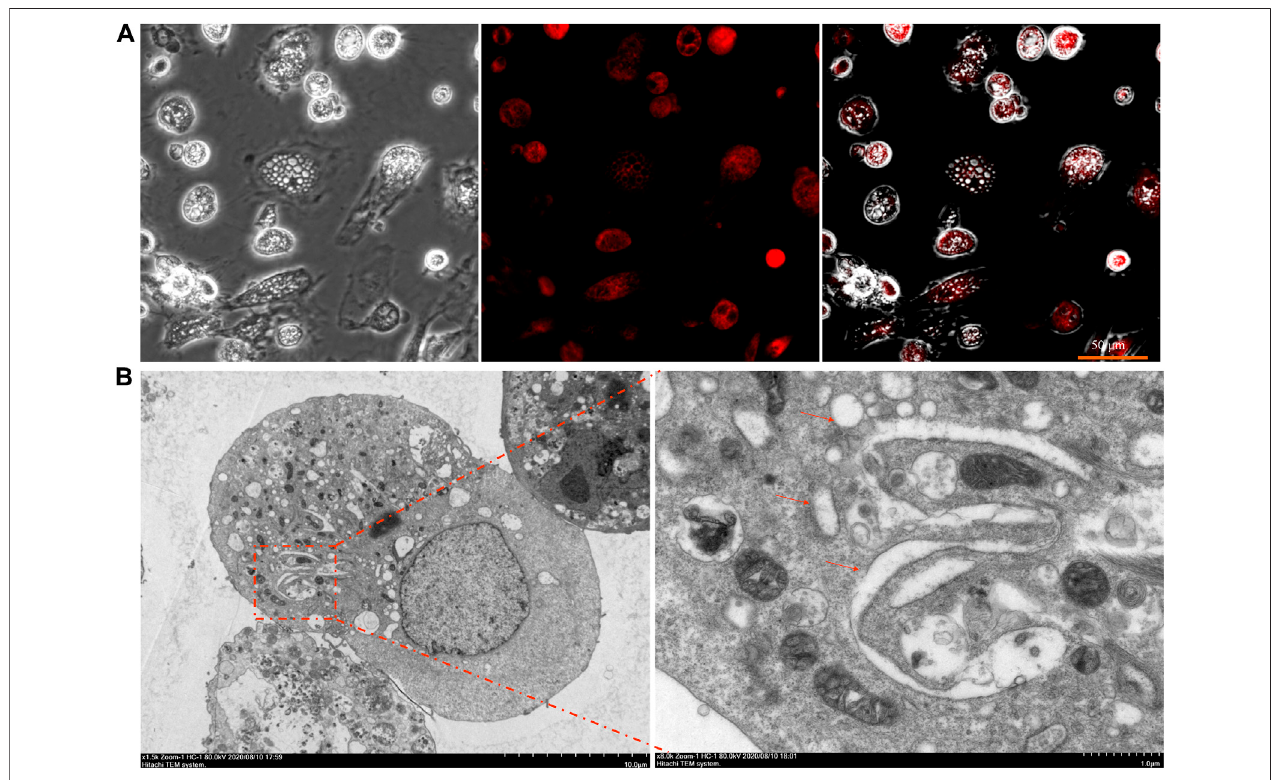
FIGURE4 | FluorescencestainingandultrastructureofSW-inducedcytoplasmicvacuolation (A) ThecytoplasmicvacuolationinducedbySWinRTECswasobserved by fl uorescence staining with ER-tracker (B) RTEC cells were treated with SW for 24 h and electron microscopy was performed. Arrows indicate the dilated ER.